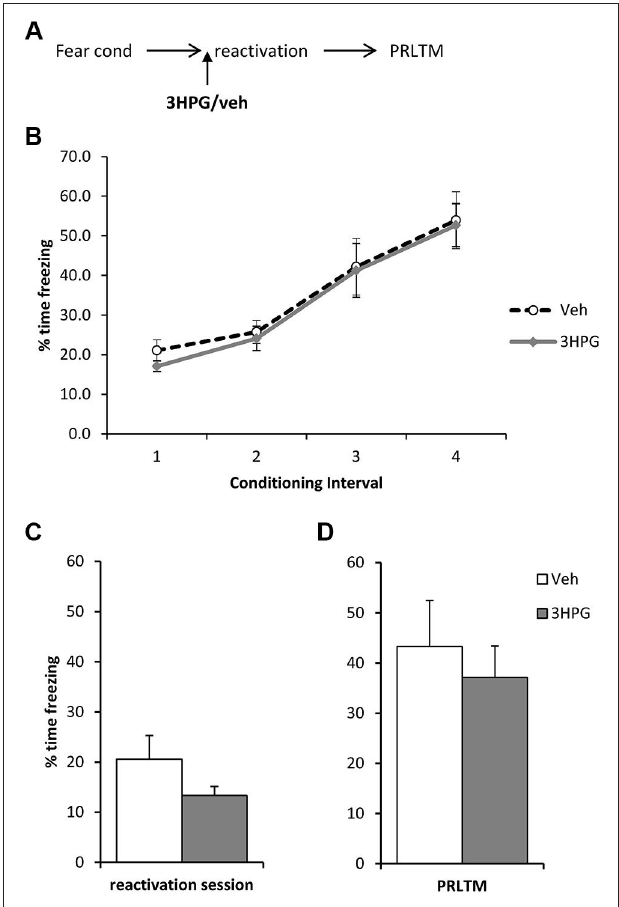
FIGURE 4 | No effect of pre-reactivation 3HPG alone . ( A ) Schematic representation of the experimental procedure. ( B ) There were no differences in contextual freezing at conditioning during the pre-shock (1), inter-shock (2 and 3) and post-final shock (4) intervals. ( C ) Intra dorsal hippocampal infusions of 3HPG did not affect the expression of contextual fear at memory reactivation. ( D ) 3HPG had no effect on contextual fear memory 24 h (PRLTM) after memory reactivation. Data presented as mean + s.e.m. ( N = 8 per